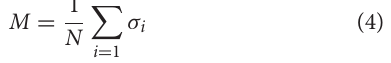
FIGURE 5 | Density of cooperators (blue) and of defectors (red) over time. Results are averaged over different runs. cooperators and of defectors over time, and Figure 6 the related average magnetization (the inset reports the variation of the Temperature). The latter is computed considering a binary variable σ = ± 1, being + 1 for cooperative cells, and − 1 for defector cells. In so doing, the magnetization (see [38])